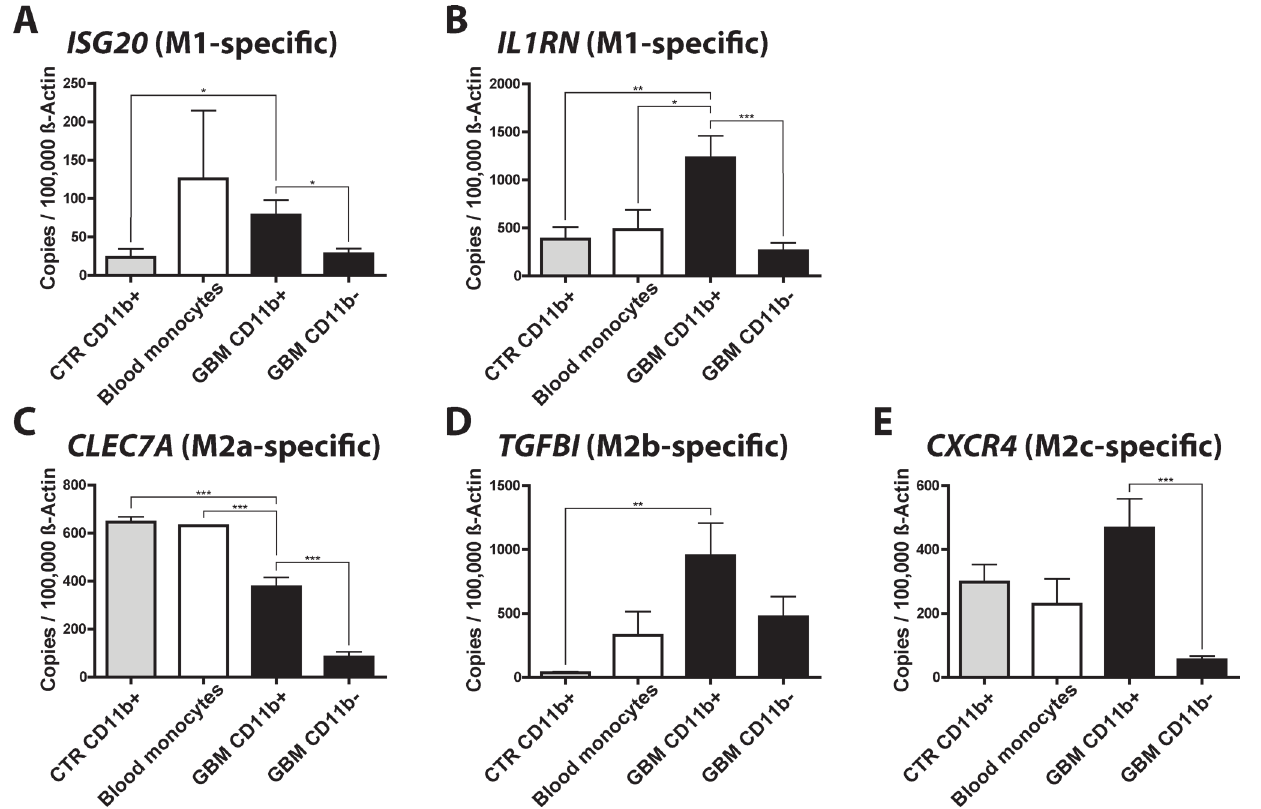
Fig 6. qPCR validation of selected M1 and M2a,b,c-specific genes in human GAMs. We determined the expression of the M1 ( IL1RN and ISG20 ), M2a ( CLEC7A ), M2b ( TGFBI ), and M2c-specific ( CXCR4 ) genes in CD11b + and CD11b - cells isolated from human GBM (CD11b + n = 13, CD11b - n = 5), control brain (CD11b + n = 5, CD11b - n = 2) and blood monocyte samples (n = 2). Bar graphs illustrate the absolute number of transcripts normalized to 100,000 transcripts of ACTB . Analysis was done by students t test. Error bars indicate the SEM. * , p < 0.05; ** , p < 0.01; *** , p <